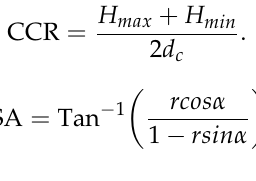
Figure 15. Chips of the studied alloy collected from the UVAT and CT processes. The CCR was calculated using Equation (2), and SA was calculated using Equation (3) for the CT and UVAT processes [47].